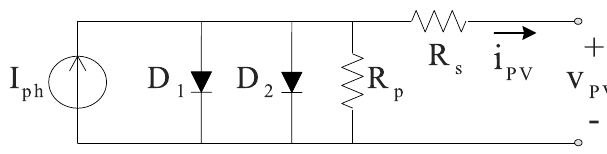
Figure 5. Double-diode model of a